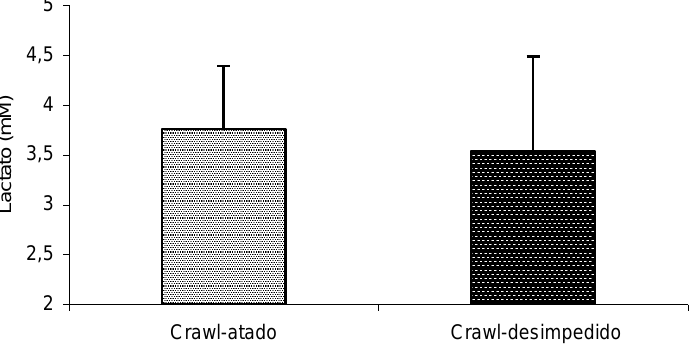
Figura 1. Comparação entre as concentrações de lactato na máxima fase estável de lactato (MFEL) no crawl-atado e